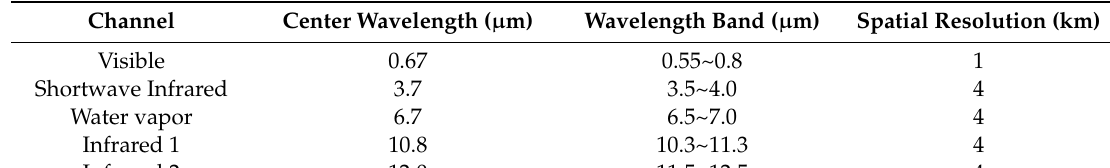
Table 2. Basic performance data of COMS.